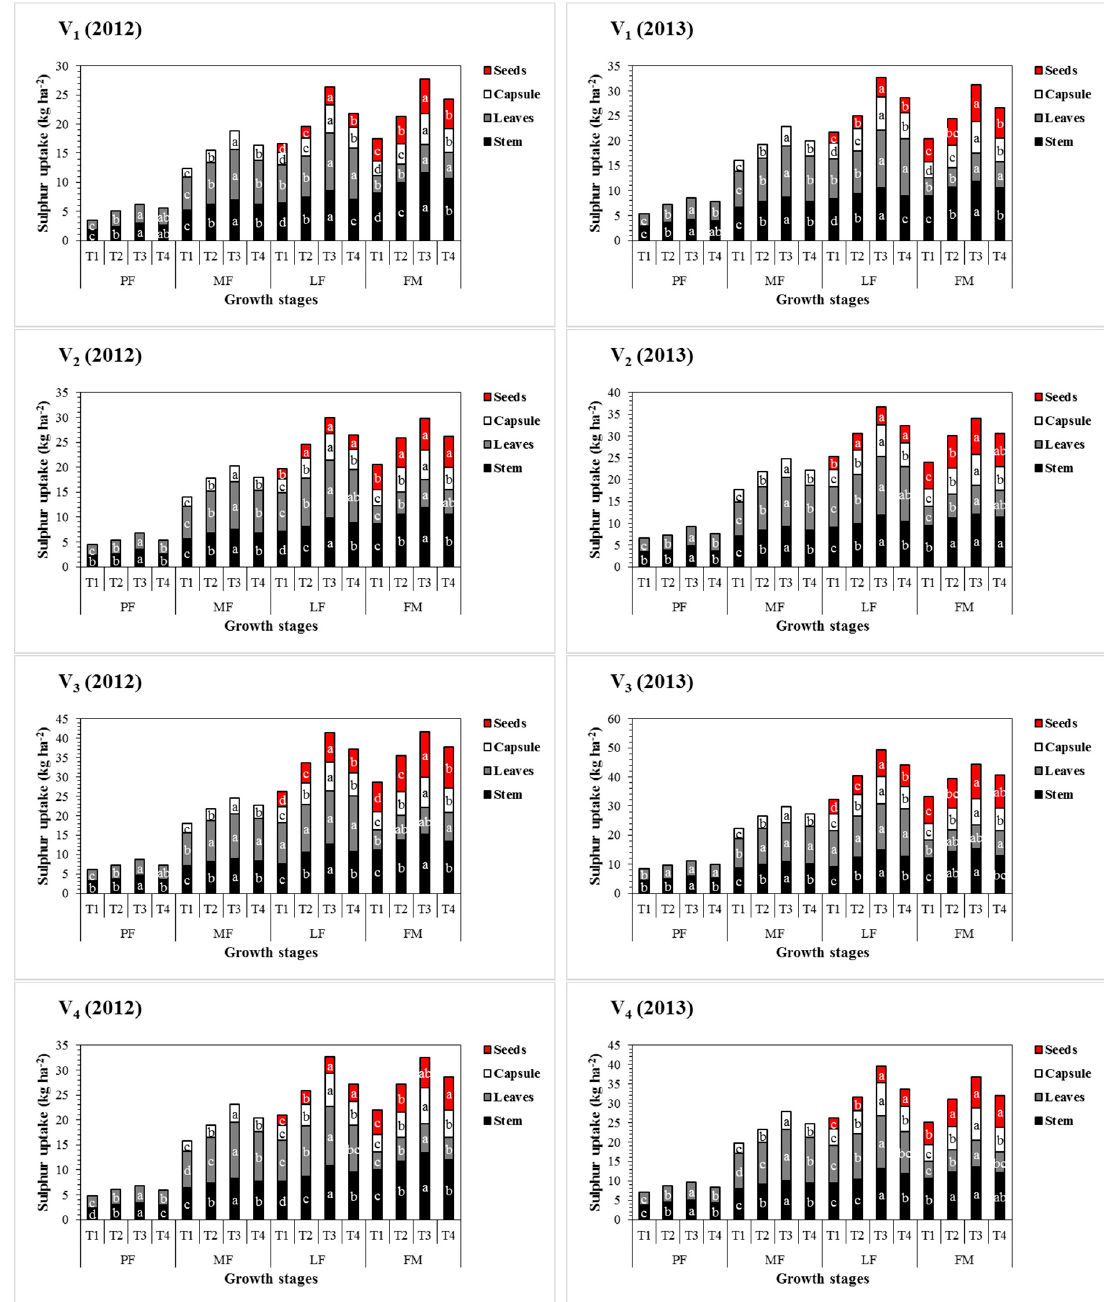
Figure 5. Sulphur distribution in different plant parts of sesame varieties as affected by sulphur treatments during 2012 and 2013 cropping seasons. PF, MF, LF and FM refer to four sesame growth stages pre-flowering, mid-flowering, late-flowering and full-maturity described by Langham (2007), V 1 , V 2 , V 3 and V 4 represent four sesame varieties SG-27, SG-30, SG-36 and SG-51 and T 1 , T 2 , T 3 and T 4 , represent four sulphur treatments 20, 30, 40 and 50 kg S ha − 1 respectively. Within a bar, different lowercase letters show a significant difference ( p < 0.05) between treatments. All the values are average of four replicates.